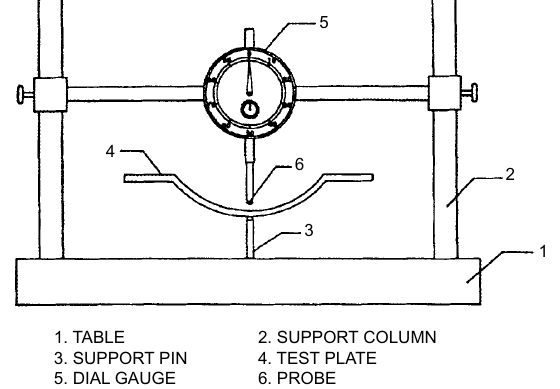
Fig. 5. Schematic of the dial gauge arrangement for measuring the depth of bulge and apex thickness